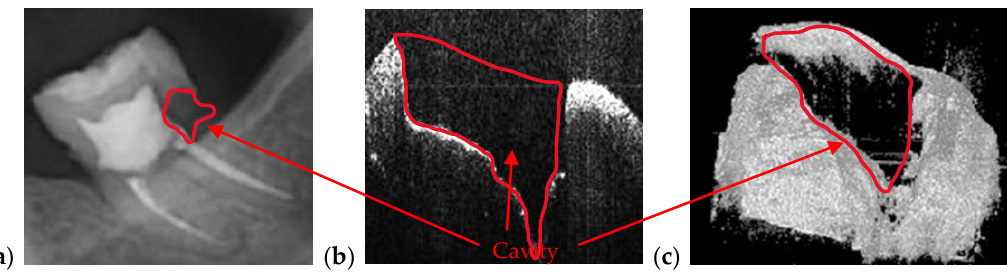
Figure 8. Cavity of a second molar from the third quadrant assessed on ( a ) a section cropped from a panoramic radiography. OCT investigation on the tooth extracted for medical purposes after performing the radiography: ( b ) B-scan and ( c ) 3D reconstruction. Patient M.N., female, age 29 years, diagnosed with a cavity on the smooth surface of the tooth and one of the tooth’s root. The latter is so large because there are two cavities connected with each other: The first one is a recurrent cavity that appeared under the filling because of an endodontic treatment; the second one appeared because of the receding gingiva and mandibular bone, which has left the tooth exposed.